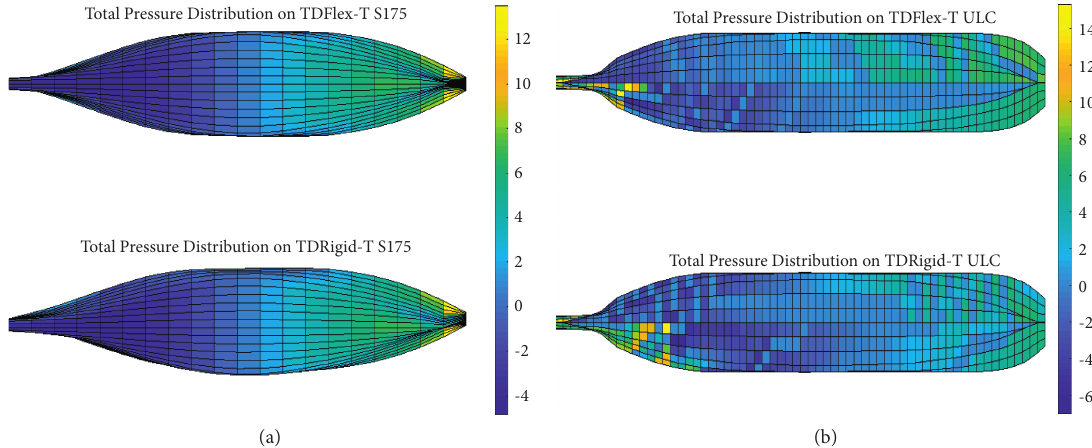
Figure 21: (a) Contour plot of pressure profile for a particular instant of time of S175 ship, F profile for a particular instant of time of ULC, F n � 0 . 25, λ / L �